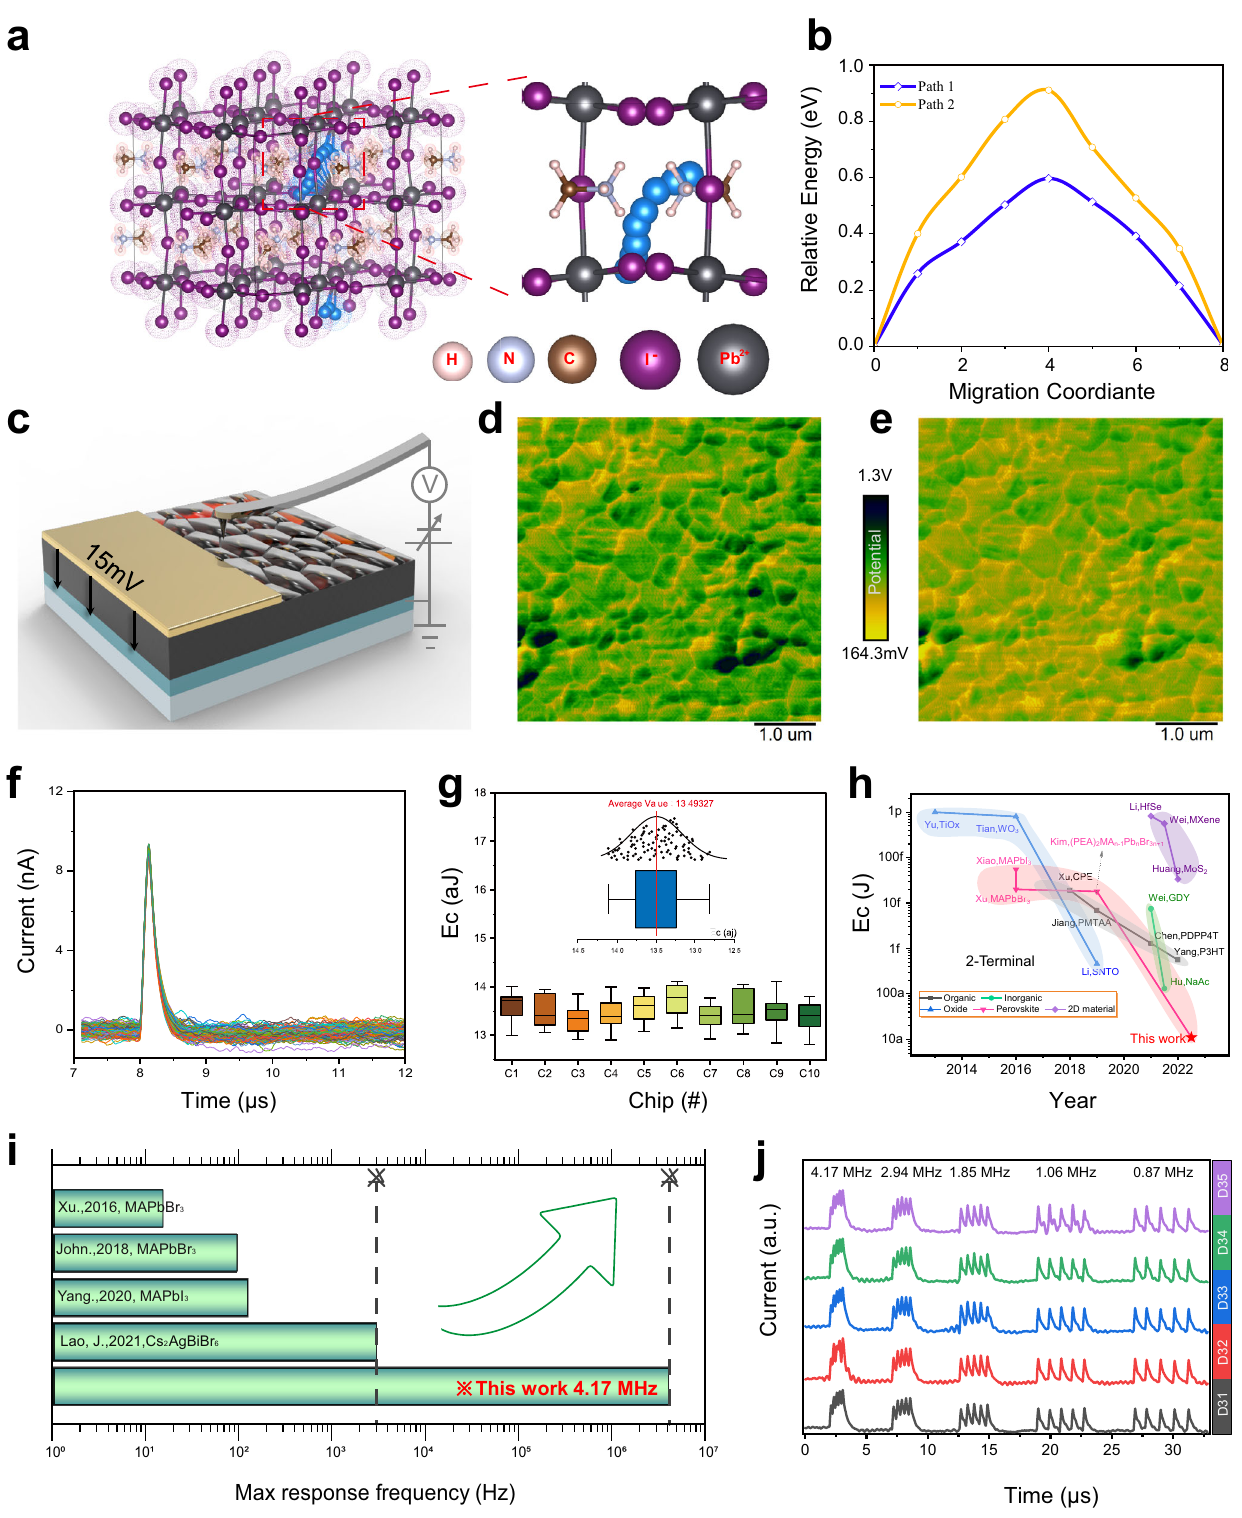
Fig. 3 | Dynamics ofionmigrationand Ultra-lowenergy consumption.a Path 1: vertical movement (blue balls) along PbI 6 octahedral layer, and Path 2: lateral movement (blue balls) through the gap of MA + . b Corresponding activation ener- gies for Path 1 and Path 2. c Schematic illustration of i-KPFM. d Surface potential pro fi le before application of 15mV bias. e Surface potential pro fi le during appli- cation of 15mV bias. f EPSC triggered by same spikes (15mV, 100ns) for 100